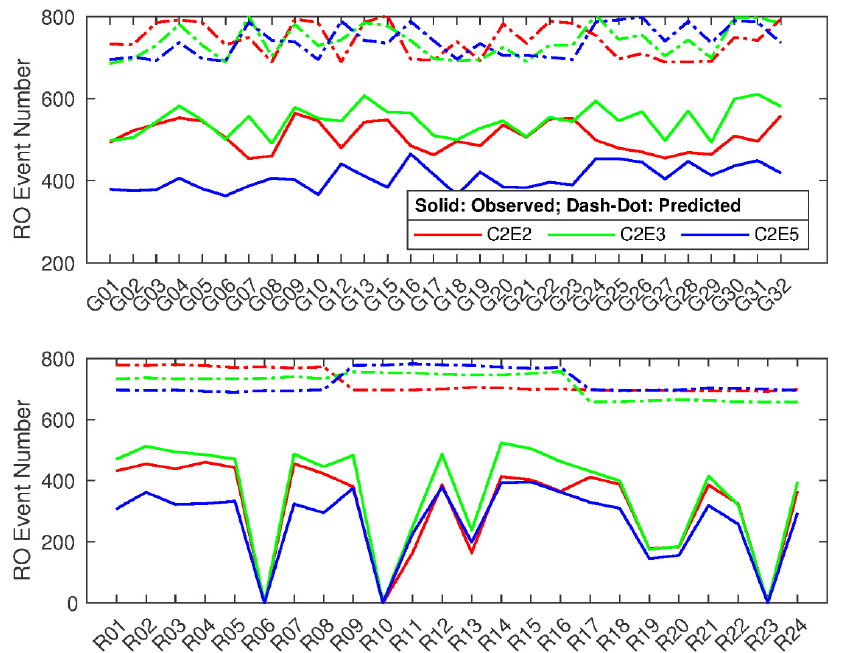
Figure 4. Radio occultation events from the predictions (dash-dot lines) and observations (solid lines) from 15 December 2020 to 15 January 2021 for COSMIC-2 satellite flight modules 2, 3, and 5. Top: GPS satellites; Bottom: GLONASS satellites.